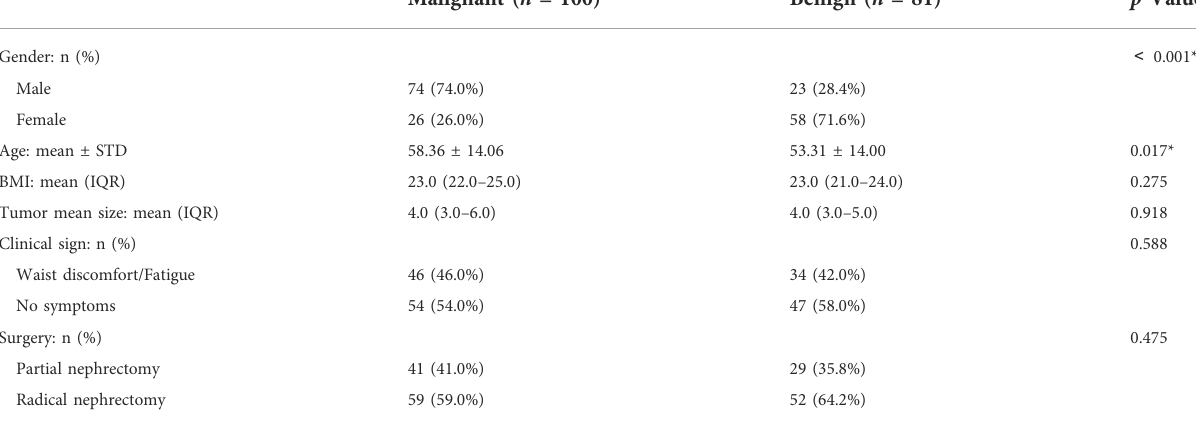
TABLE 1 Patient